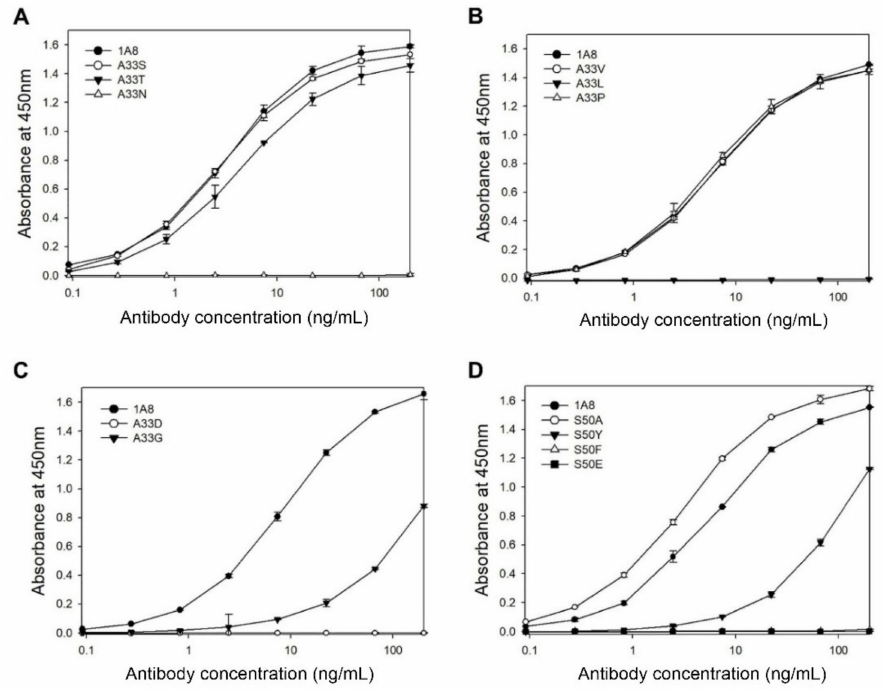
Figure 4. Analysis of the antigen-binding activities of 1A8 variants with a mutation at position 33 in the HCDR1 ( A – C ) or at position 50 in the HCDR2 ( D ) by indirect ELISA. The culture supernatants containing each antibody (200 ng/mL) was serially diluted and subjected to the ELISA. Values were obtained from duplicate wells and are expressed as the mean ± SD.